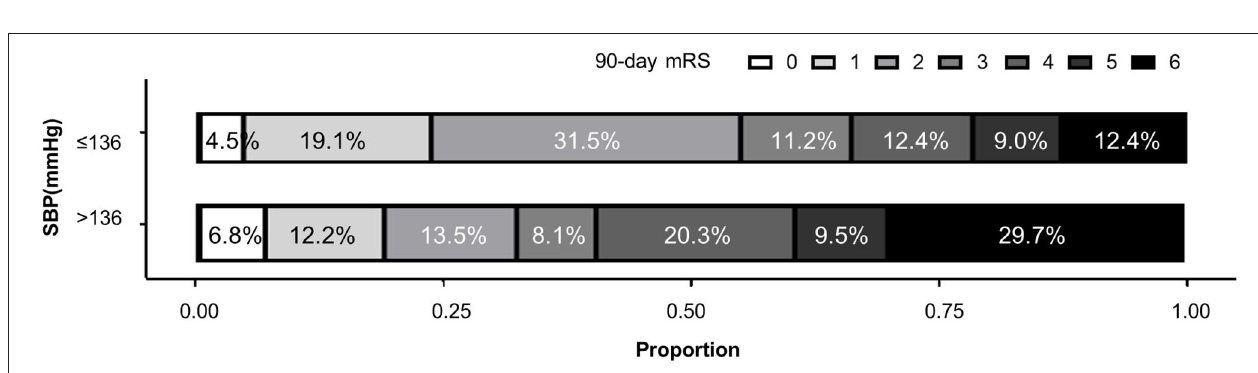
FIGURE 3 | Distributions of 90-day modified Rankin Scale (mRS) in patients with different first postoperative SBP